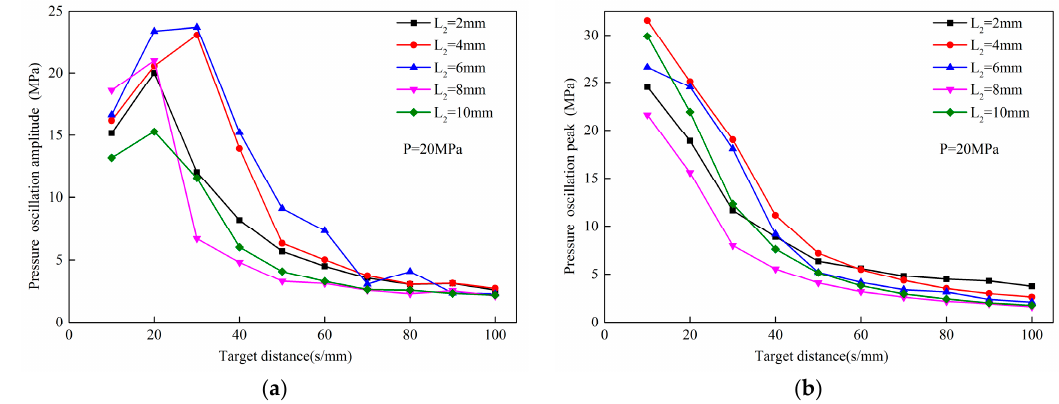
Figure 12. Effect of L 2 on nozzle performance at 20 MPa pressure. ( a ). c urves of nozzles with different L 2 on pressure pulsation amplitude at different target distances. ( b ). c urves of nozzles with different L 2 on pressure oscillation peak at different target distances.